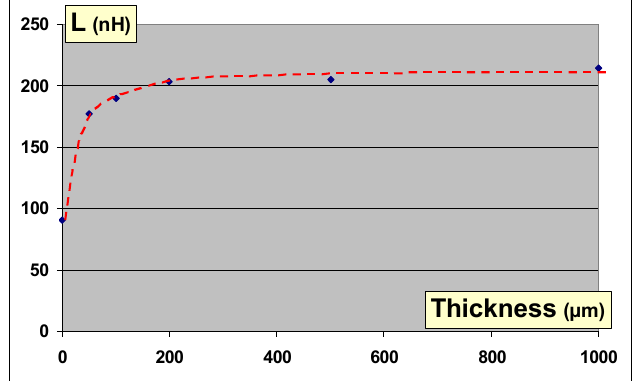
Figure 9: Measured inductance of the integrated inductor deposited on a thick micro-machined layer versus its thickness at low frequency